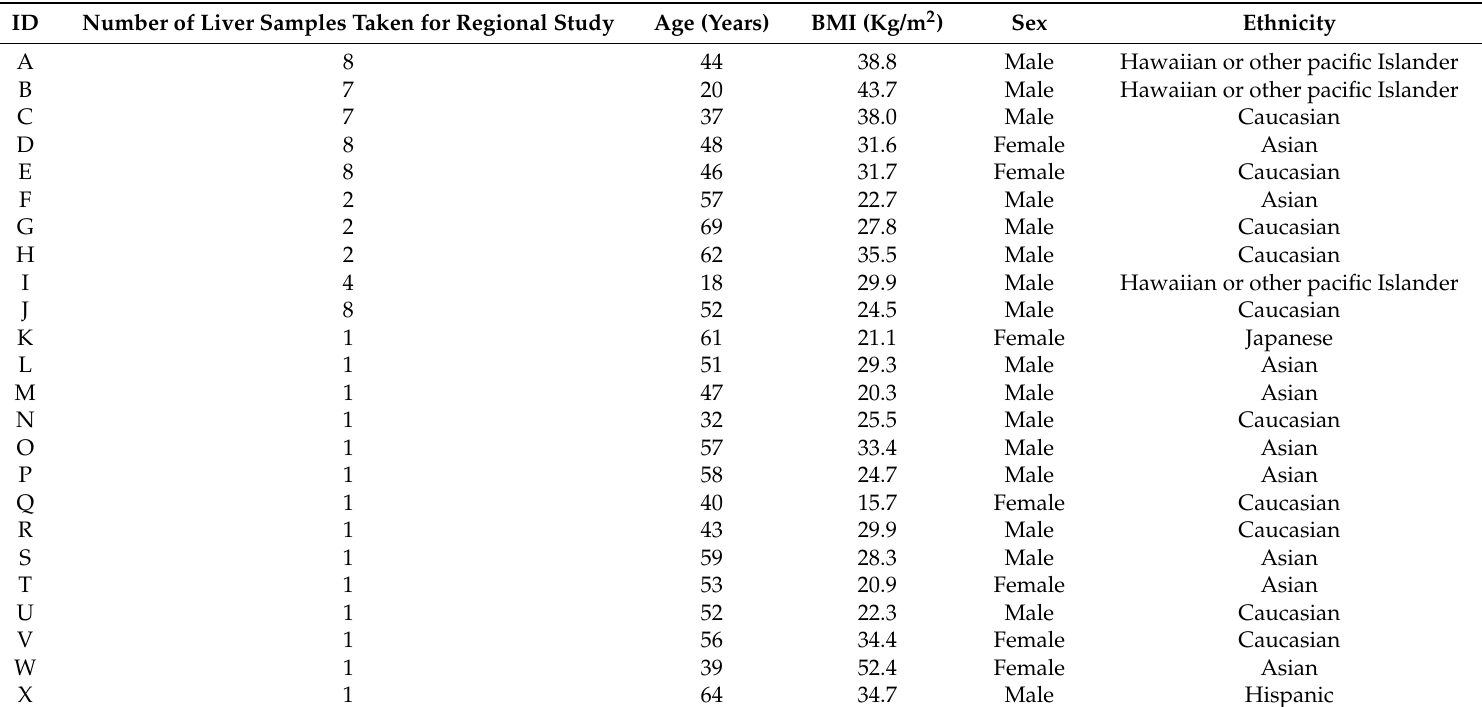
Table 1. Demographic information of the donors used to investigate regional ATP Binding Cassette B1 (ABCB1) expression in the liver.